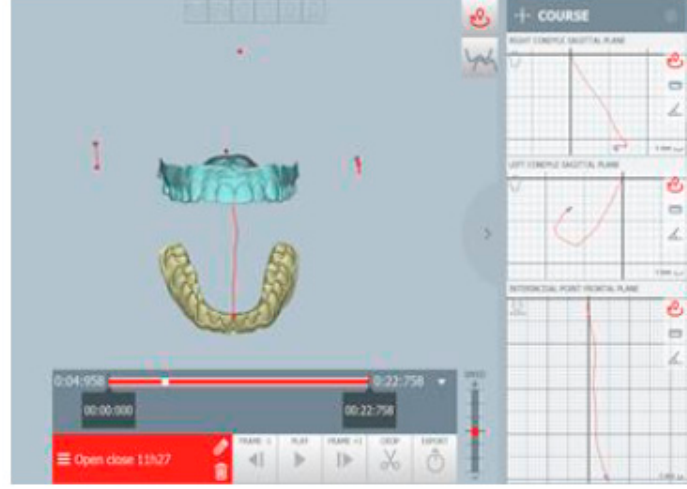
Figure 17. Mandibular kinematic during opening. There was a normal opening amplitude, with deflection to the left side. There were some slight deviations to the right and left, not al- ways present during the opening movements. The right condylar path showed hypermobility in maximum